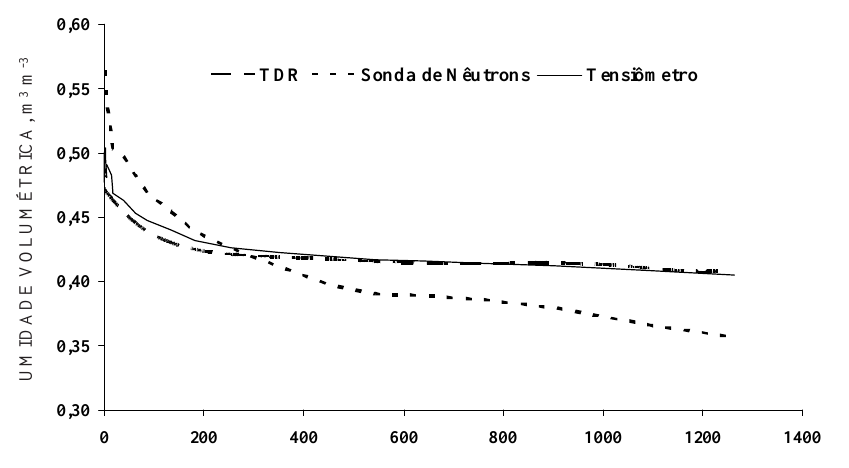
Figura 1. Variação da umidade volumétrica com o tempo para o tensiômetro, sonda de nêutrons e TDR, para a profundidade de 0,70